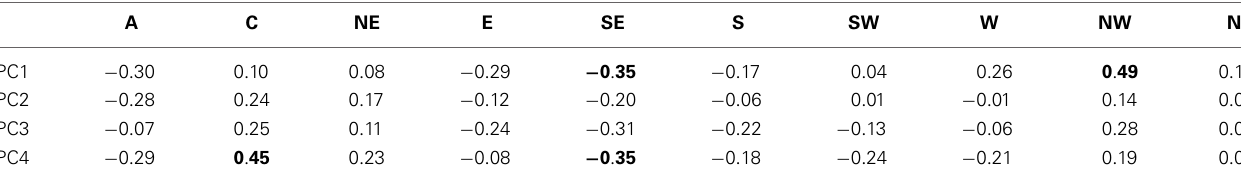
Table 4 | As in Table 3, but for summer.